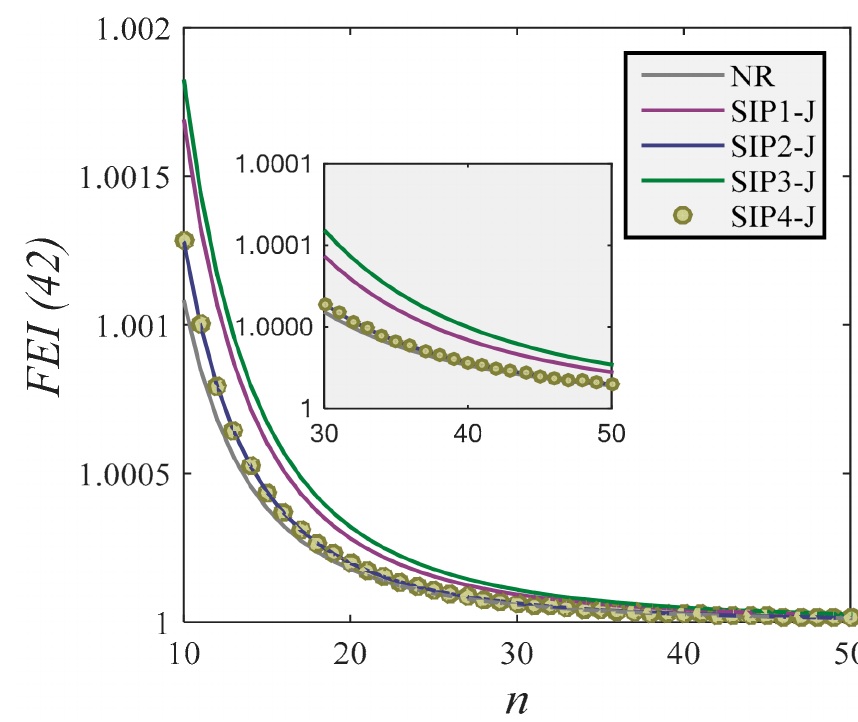
Figure 3. Efficiency index (42) for different PF